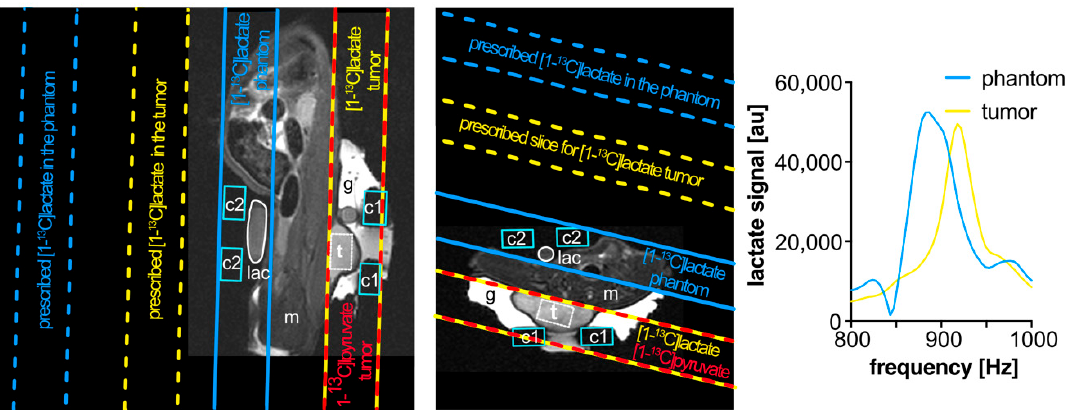
Figure 1. Representative anatomical T2-weighted (rapid acquisition with relaxation enhancement (RARE)) images in sagittal ( A ) and axial ( B ) orientations, with oblique spectroscopy slice geometry shown for a subcutaneous tumor ( t ) in a rat and for a thermal lactate ( lac ) phantom for transmit power calibration. To measure within the target tumor, with the scanner reference frequency set to that of [1- 13 C]pyruvate, the slice geometry is prescribed twice: once on the target tumor for [1- 13 C]pyruvate (yellow-and-red outlines) and again offset by the chemical shift displacement of [1- 13 C]lactate (dashed yellow outlines). This produces excitations that, at the location of the tumor, alternate between [1- 13 C]pyruvate and [1- 13 C]lactate frequencies. An additional slice may also be prescribed (dashed blue outlines) to target lactate in the phantom (solid blue outlines). Carbopol ® 980 gel ( g , bright contrast) was placed around the tumor to improve its B0 field uniformity. The locations of the 13 C surface receive coils ( c1 and c2 , light blue outlines), muscle ( m ), and a point-resolved spectroscopy (PRESS) voxel (white box surrounding t ) for shimming on proton signal within the tumor are also marked. Magnitude spectra ( C ) from [1- 13 C]lactate in the phantom (blue) and from hyperpolarized [1- 13 C]lactate in the tumor (yellow) after injection, exhibiting a frequency shift between the two sources of lactate signal. In cases where this shift is large, the placement of a slice prescribed to measure within the phantom may benefit from additional spatial offset to compensate for that frequency shift in order to excite the 13 C in the phantom.